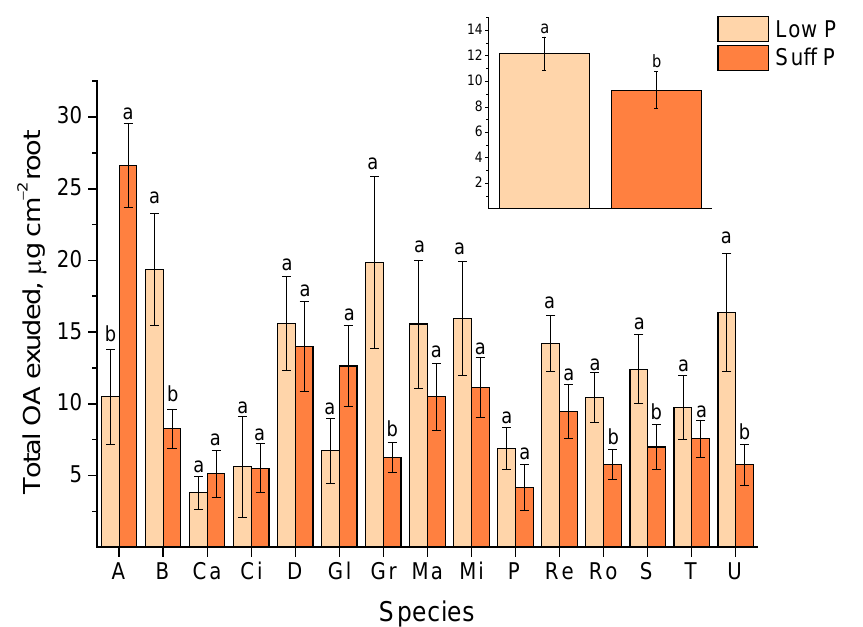
Figure 3. Total organic acid (OA) exuded by the roots of fifteen eucalypt species grown under low (Low P, clear color) and sufficient (Suff P, dark color) phosphorus concentrations. Different letters indicate significant differences between low and sufficient P concentrations within each species by the Tukey test ( p < 0.05). Species abbreviations: A— E. acmenoides , B— E. brassiana, Ca— E. camaldulensis , E. microcorys , P— E. pellita , Re— E. resinifera , Ro— E. robusta , T— E. tereticornis , S— E. saligna , U— E. urophylla .